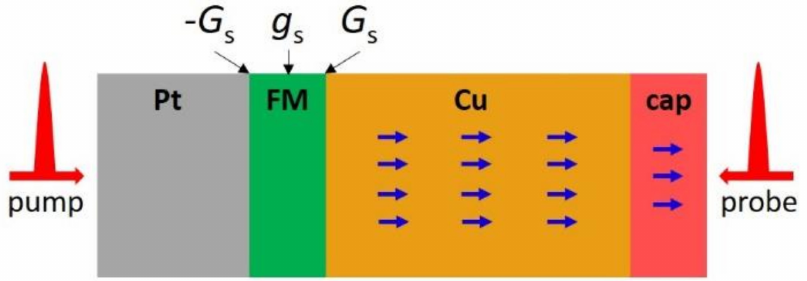
Figure 1. Schematic of the experiment. The sample structure is Pt/FM (ferromagnetic metal)/Cu/cap, where cap is Au or Pt. The pump energy drives the ultrafast demagnetization and the spin-dependent Seebeck effect on FM. The ultrafast demagnetization generates spins at the bulk of FM ( g s ), and the spin-dependent Seebeck effect generates spin at the FM/NM (non-ferromagnetic metal) interfaces ( G s ). When the FM thickness is small, the spin generation at the Pt/FM interface is the negative value of that at the FM/Cu interface. The generated spins on FM diffuse to adjacent layers and induce a spin accumulation on Cu and cap (blue arrows). The spin accumulation on Cu and cap rotates the polarization of the probe upon